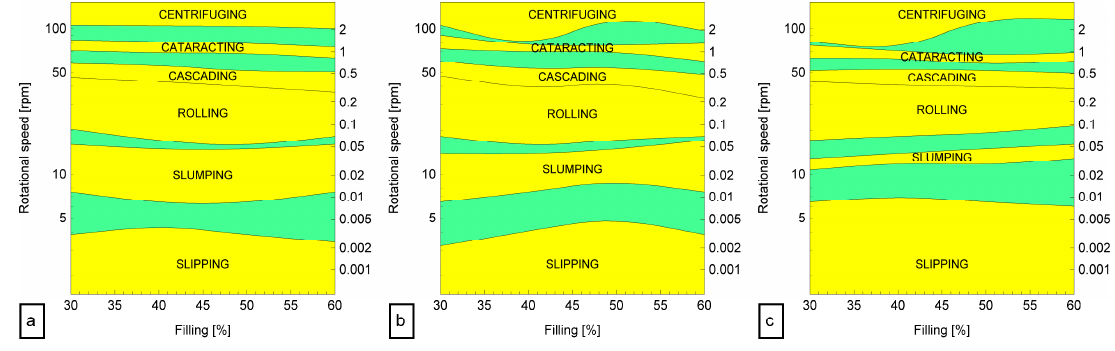
Figure 6. Bed behavior (BB) for charge 1 ( a ), charge 2 ( b ), and charge 3 ( c ).